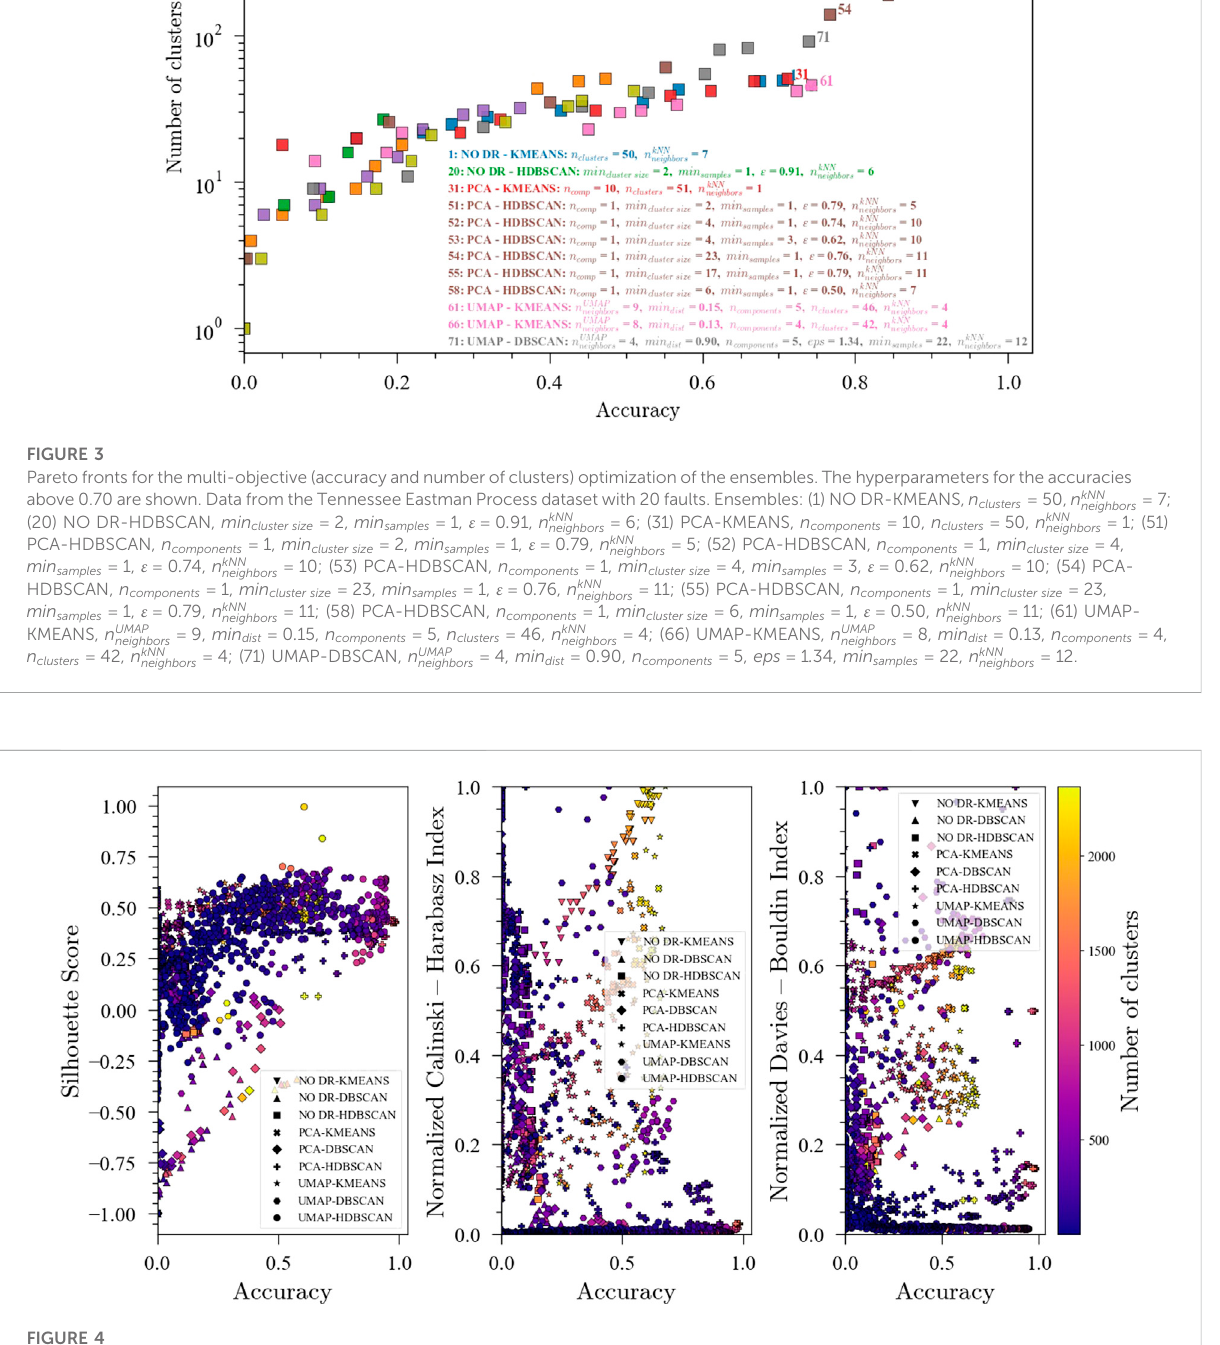
FIGURE 4 Evolution of the Silhouette Score, Davies-Bouldin Index and Calinski-Harabasz Index with accuracy during optimization for the Tennessee Eastman Process dataset with 20